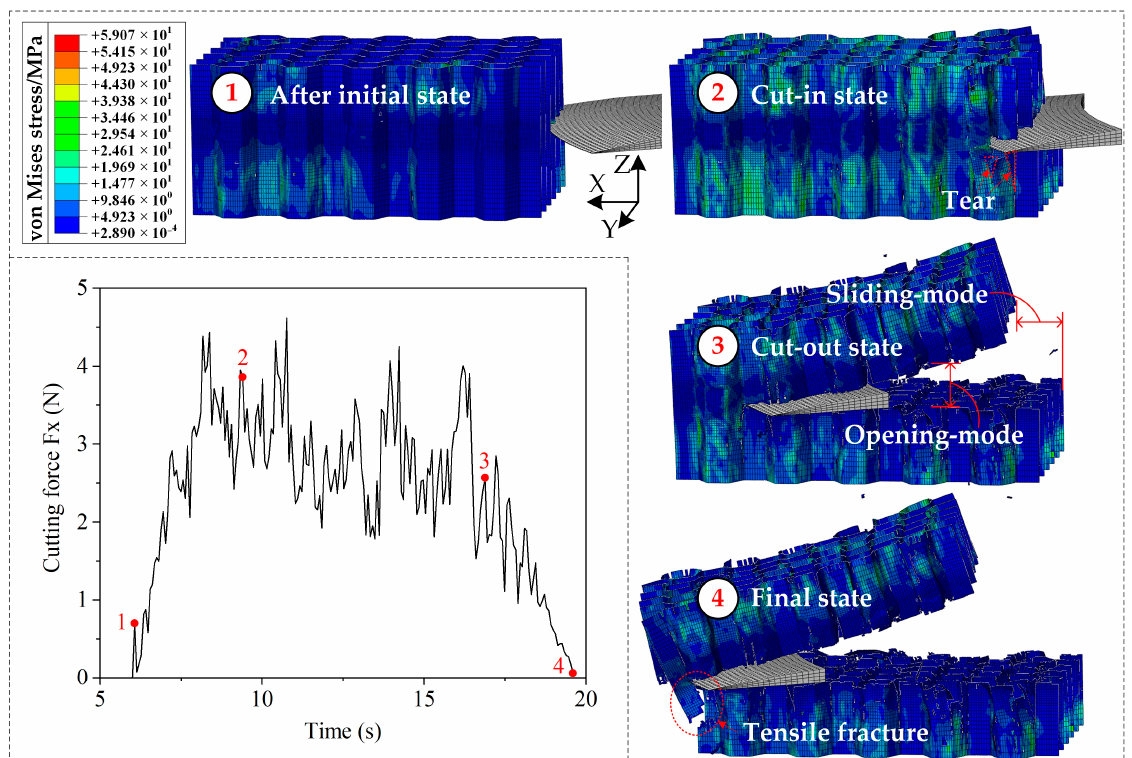
Figure 6. Predicted cutting process with sharp disc cutting tool by FEM.